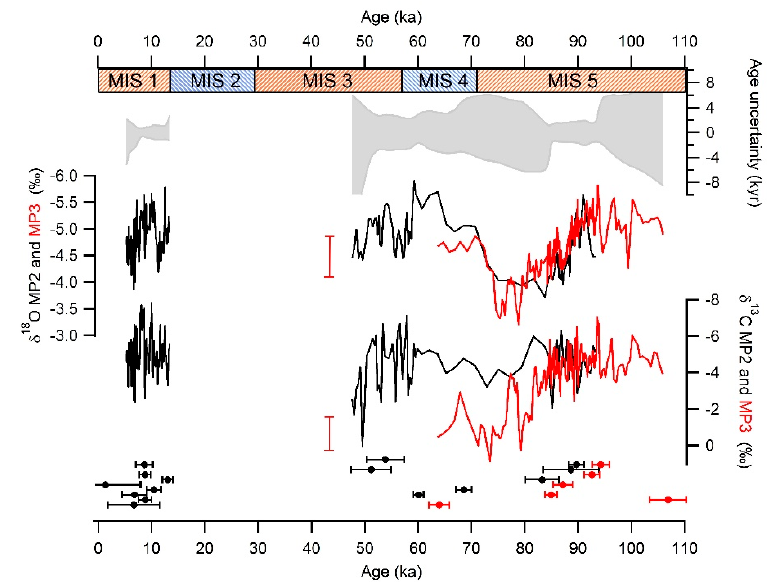
Figure 4. The δ 18 O and δ 13 C time series of the MP-2 and MP-3 speleothems. Since the chronology of the youngest part of the MP-3 speleothems can be only roughly estimated by 14 C dating and cannot be anchored to the particular δ 18 O and δ 13 C values, their ranges ( − 4.9 to − 4.1‰ and − 1.6 to 0.1‰, respectively) are given only by error bars. Bottom: U-Th ages with 2 σ uncertainty for MP-2 (black) and MP-3 (red) stalagmites.